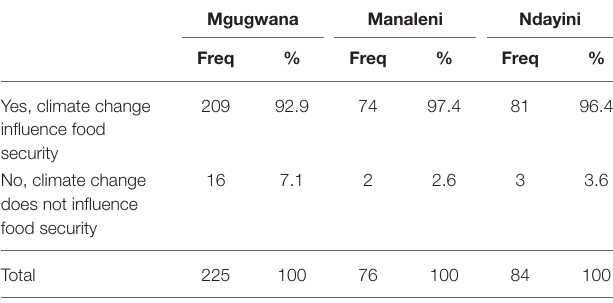
TABLE 3 | Influence of climate change on food